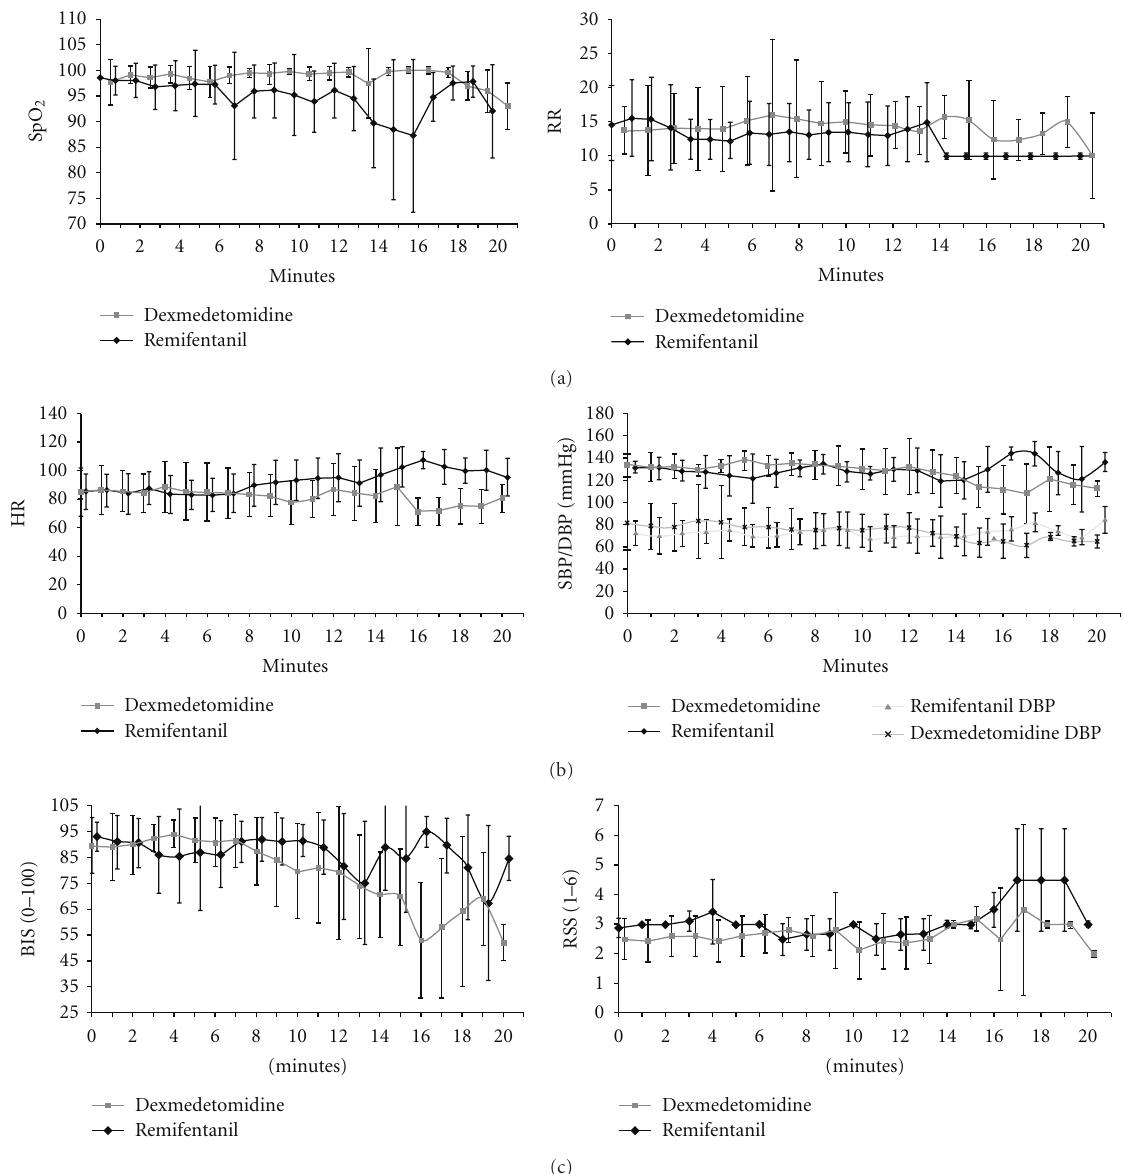
Figure 1: Mean physiologic variables from beginning to end of intubation. (a) includes oxygen saturation (SpO 2 ) and respiratory rate (RR). (b) includes heart rate (HR) and systolic (SBP) and diastolic blood pressure (DBP). (c) includes sedation variables bispectral index (BIS) and Ramsay Sedation Scale (RSS).